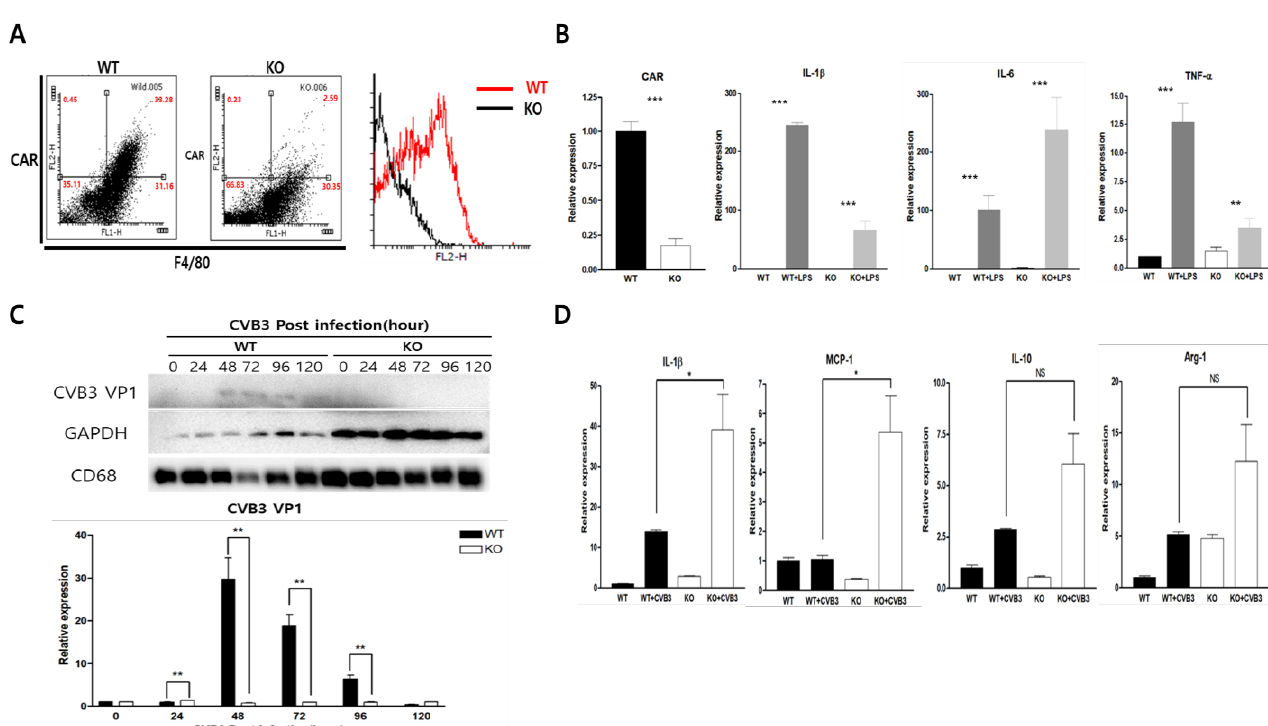
Figure 2. Generation of macrophage-specific CAR knockout mice. ( A ) PMC was isolated from wild- type (WT) and CAR knockout (KO) mice. The PMC was subjected to immunofluorescent staining using indicated antibodies and then subjected to FACS analysis. ( B ) RNA was extracted from WT and KO mice PMCs after LPS stimulation, after which CAR, IL-1beta, IL-6, and TNF-alpha mRNA levels were confirmed by real-time PCR. ( C ) WT and KO mice were infected with CVB3. The protein was extracted in a time-dependent manner and then subjected to western blot analysis using the indicated antibodies. ( D ) The mRNA levels of M1 (IL-1b and MCP-1) and M2 (IL-10 and Arg-1) polarity genes were confirmed by real-time PCR from CVB3-infected WT and KO PMCs. All data are expressed as the mean ± SEM from independent repeat experiments. NS, not significant, * p < 0.05, ** p < 0.01 and *** p < 0.001 according to the two- tailed Student’s t -test.